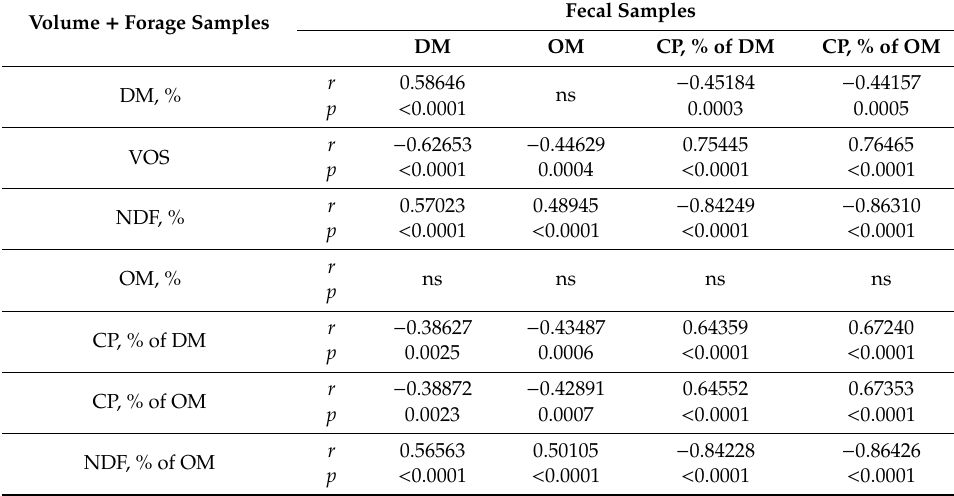
Table 8. Correlation coe ffi cient ( r , p -value) between nutrient concentrations in forage + volume samples and in fecal samples from 12 Gotlandsruss kept in three enclosures between May 2014 and September 2016 without supplementary feeding. DM = dry matter, OM = organic matter, CP = crude protein, VOS = digestibility coe ffi cient of organic matter, NDF = neutral detergent fiber. Volume + Forage